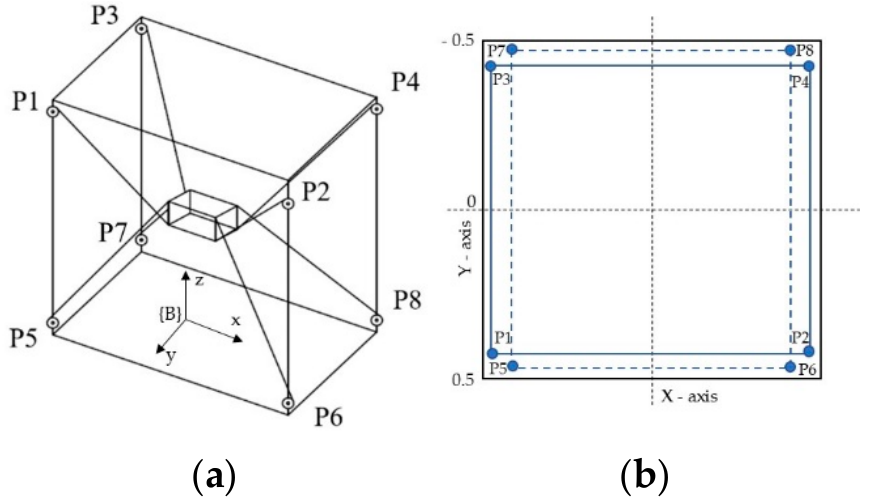
Figure 1. Schematic diagram of the CDPR system: ( a ) diagram of 6–DOF CDPR; ( b ) asymmetric pulley locations.